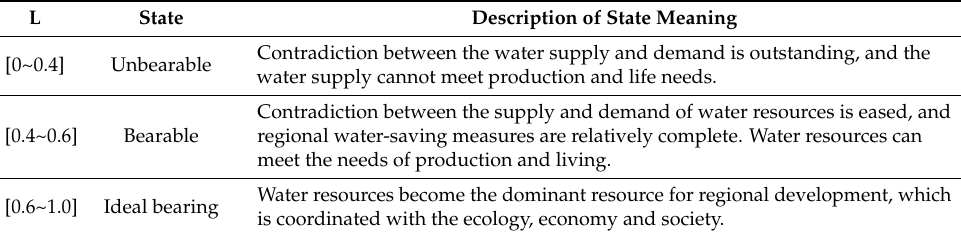
Table 5. Evaluation index grading standard for the